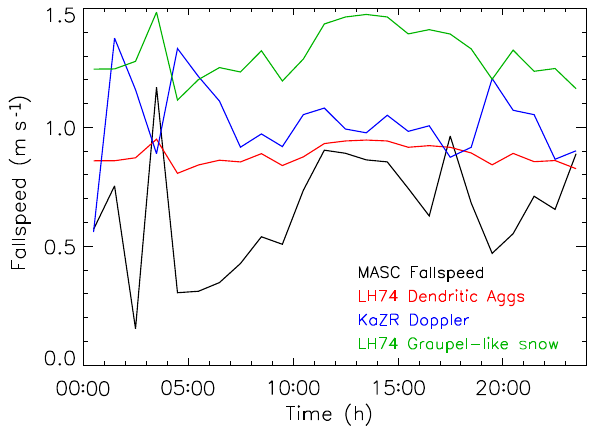
Figure 5. MASC-observed fall speeds for the 23 April snowfall event at Barrow are plotted in black. Results are compared to cal- culations from LH74 parameterization schemes for crystal types similar to those observed by MASC during the storm event. Green represents graupel-like snow, while red represents dendritic aggre- gates. Near-surface Doppler fall speeds from the KAZR are plotted in blue. The MASC fall-speed observations had correlation coef- ficients of − 0.34 and 0.66 with the KAZR and LH74 fall speeds,